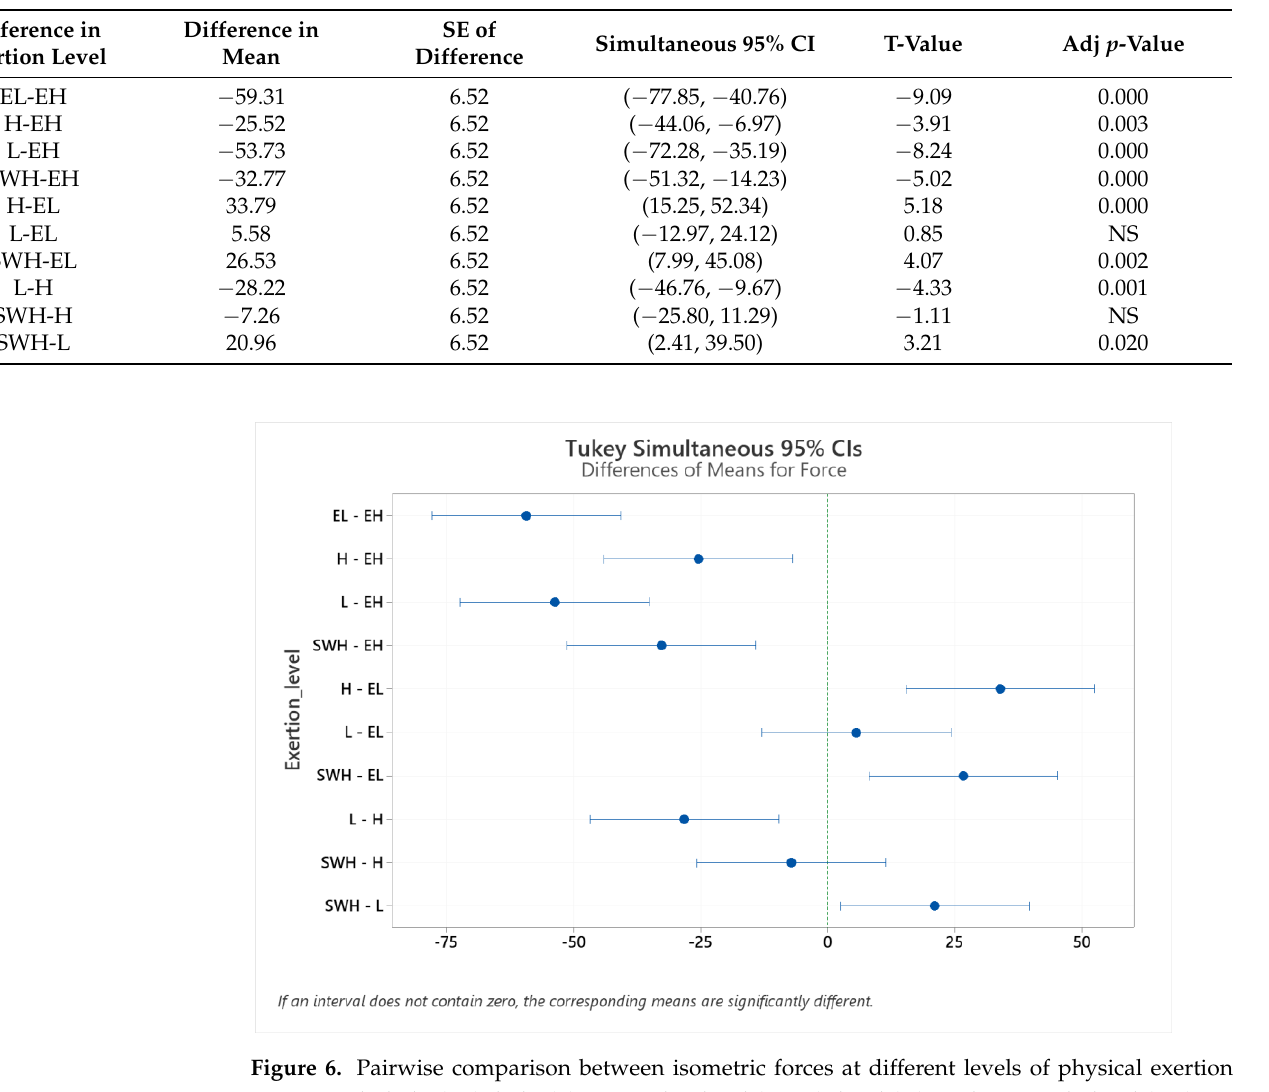
Table 6. Mean and standard deviation for the rate of perceived physical comfort at each exertion level .